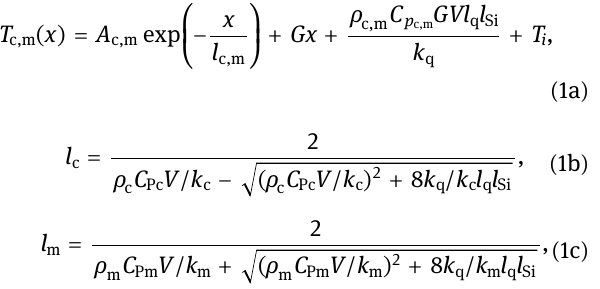
Figure 8: Calculated thermal fi eld in the growth direction at various growth rates [ 90 ] . When the growth rate is low, the temperature gradient in the melt at the interface is positive, whereas it becomes negative at a high growth rate. The calculated critical growth rate where the temperature gradient changes from positive to negative is 109 µm · s − 1 under our experimental